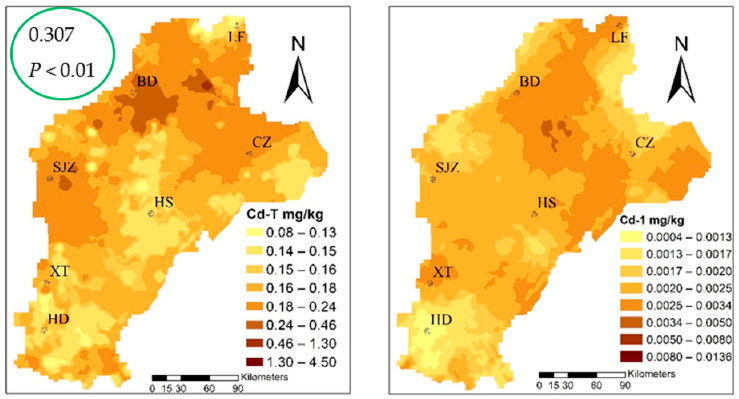
Table 2. Concentration statistics for each medium and seven types of fractions of Cd elements (unit: mg/kg, except for water: